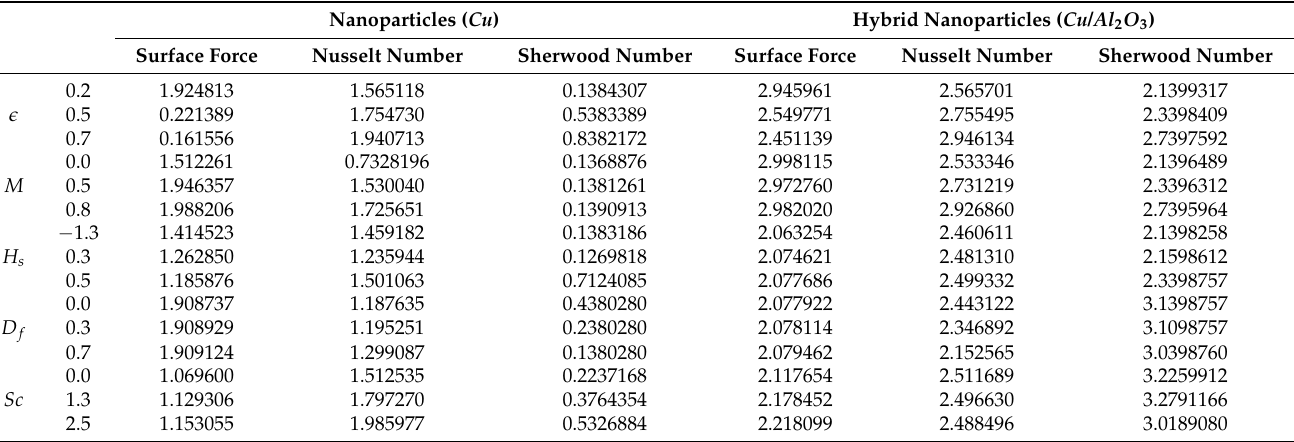
Table 3. Numerical values of ( Ree ) 0.5 Nu cles and hybrid